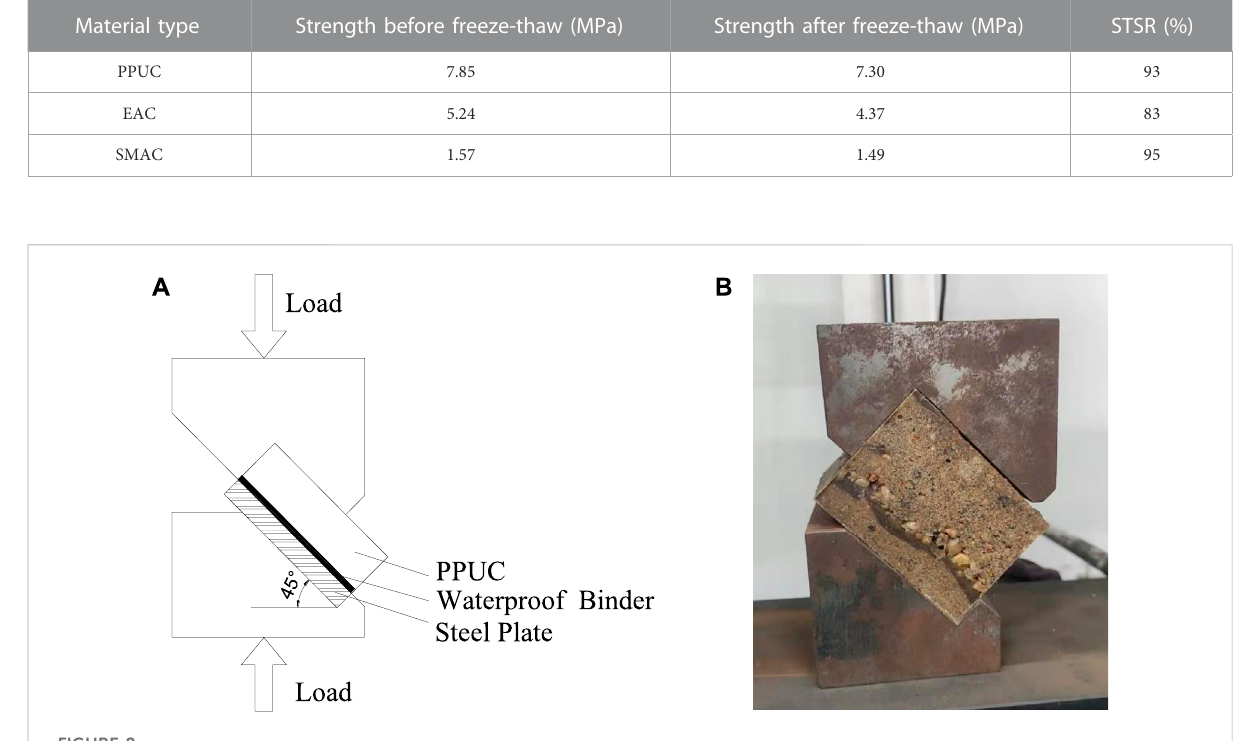
FIGURE 8 Shear test procedure. (A) Schematic of the shear test; (B) Test photo of the shear test.